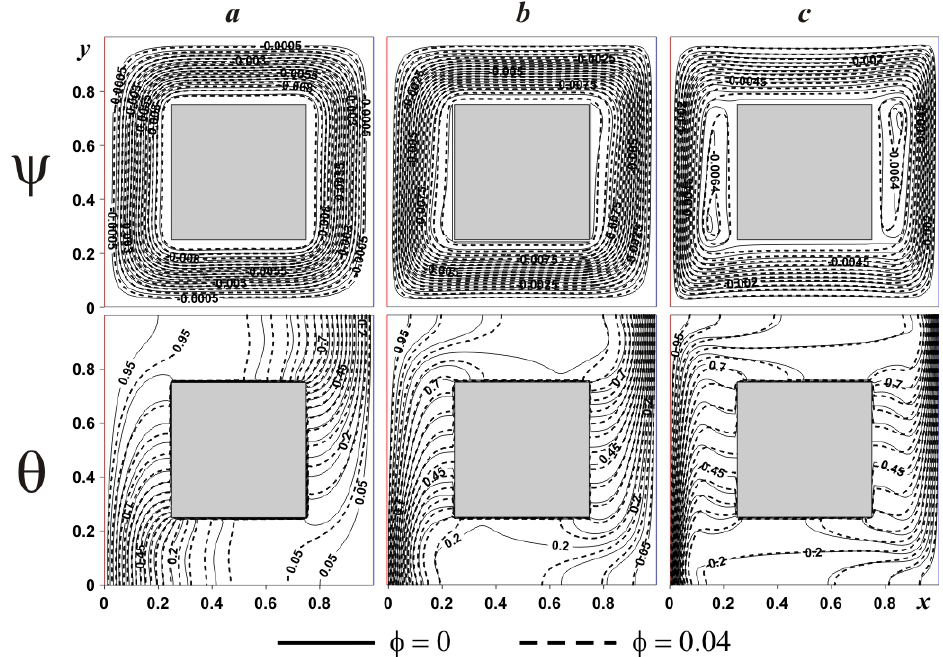
Figure 7. Isolines of ψ and θ for adiabatic internal body at δ = 0.5 and different Ra and φ : ( a )— Ra = 10 4 , ( b )— Ra = 10 5 , ( c )— Ra = 10 6